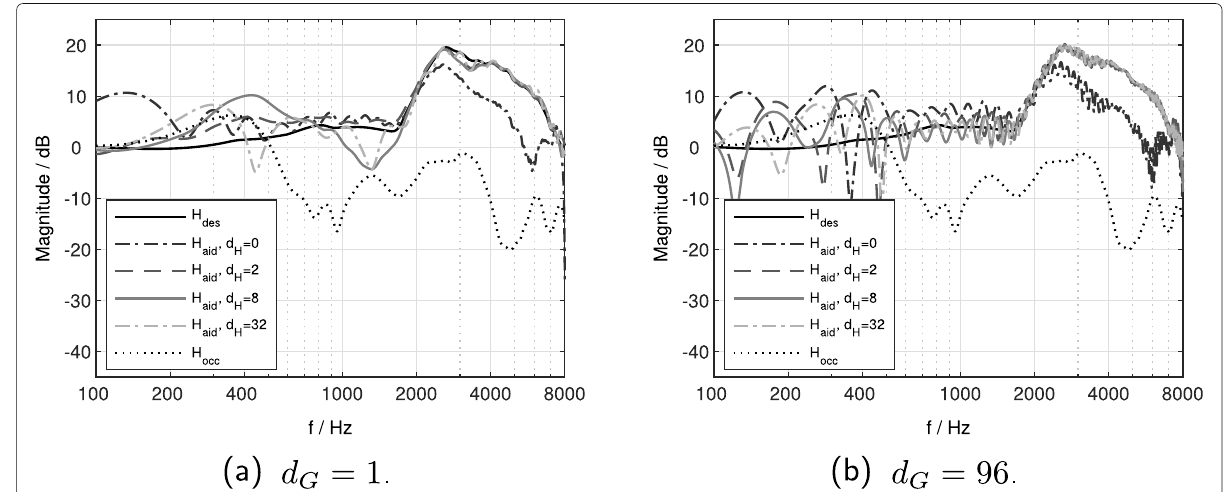
Fig. 3 Magnitude responses of the occluded ear transfer function H occ ( q ) , the aided ear transfer function H aid ( q ) and the desired open ear transfer function H des ( q ) for different values of d H using N = 1 loudspeaker, and G 0 = 0dB for a d G = 1 and b d G = 96 results observed in [13, 14]. It should be noted that using a larger acausal delay may result in comb-filtering effects, in particular in frequency regions where the occluded ear transfer function H occ ( q ) and the desired open ear transfer function H des ( q ) are of similar magnitude (here the frequency region below approximately 500Hz). In